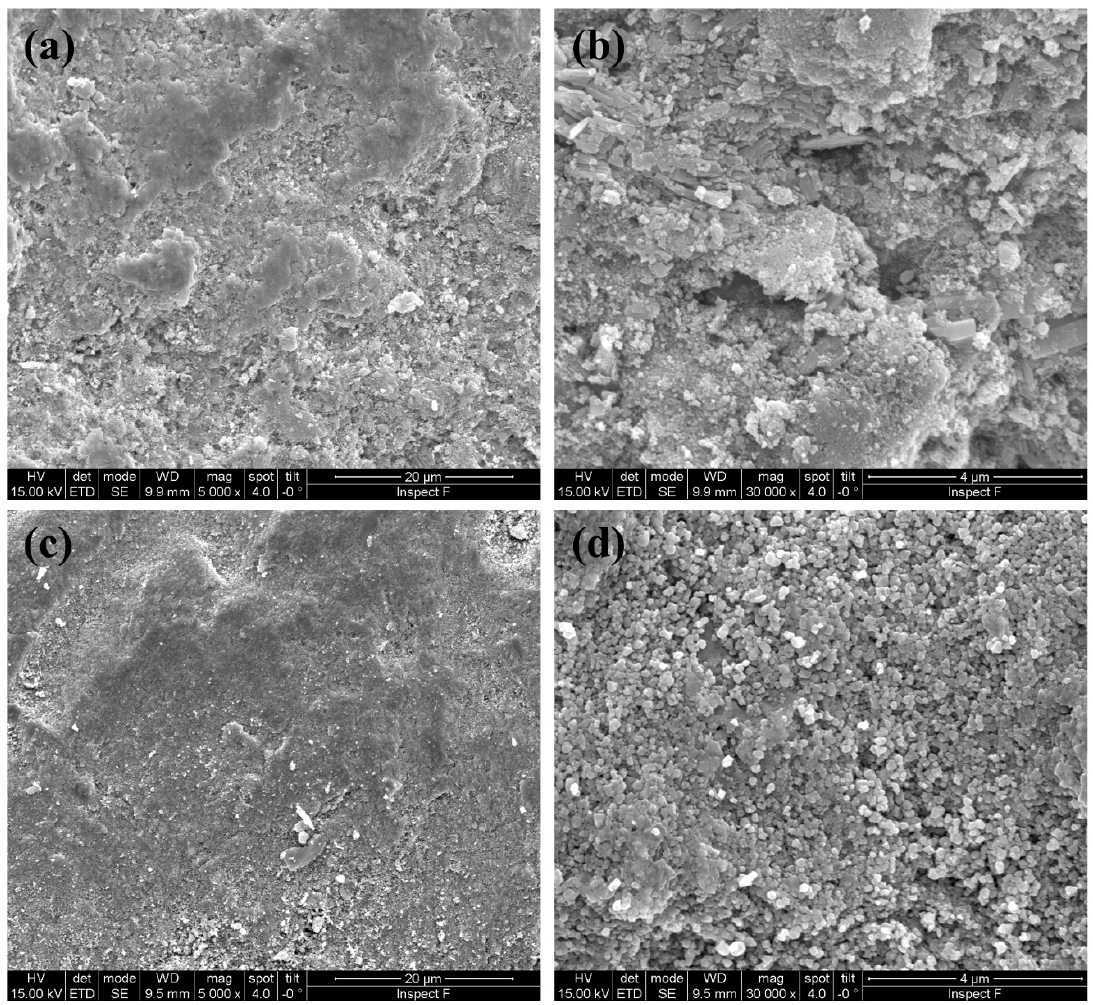
Figure 5. SEM micrographs of flash-sintered SPDC-AC ( a , b ) and GPDC-AC ( c , d ) samples under a current limit of 20 mA/mm 2 .